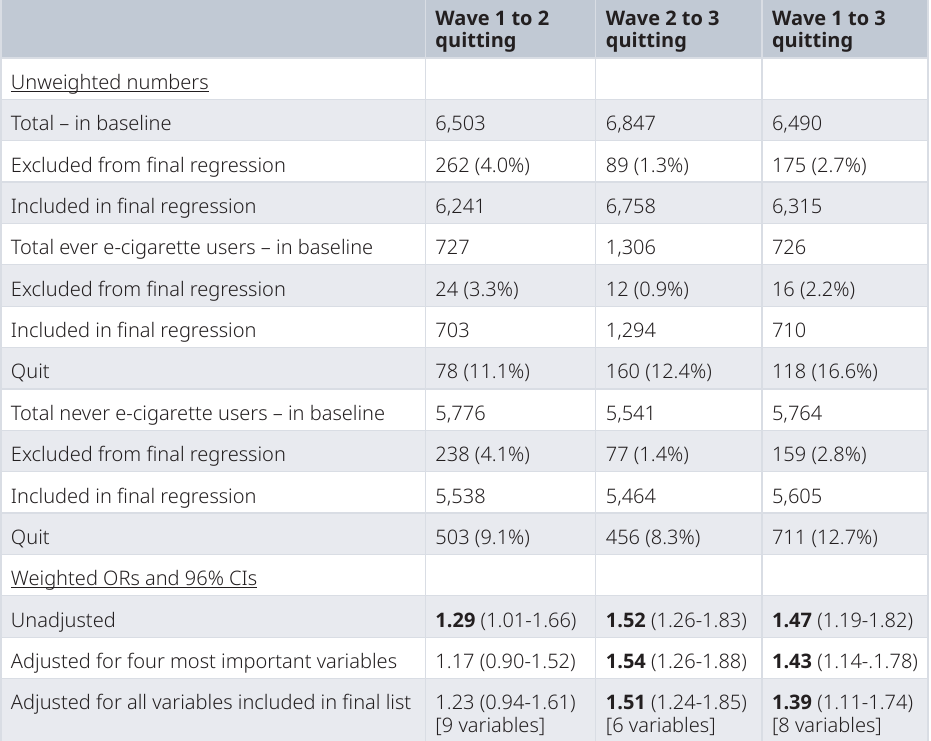
Wave 1 to 2 Wave 2 to 3 quitting